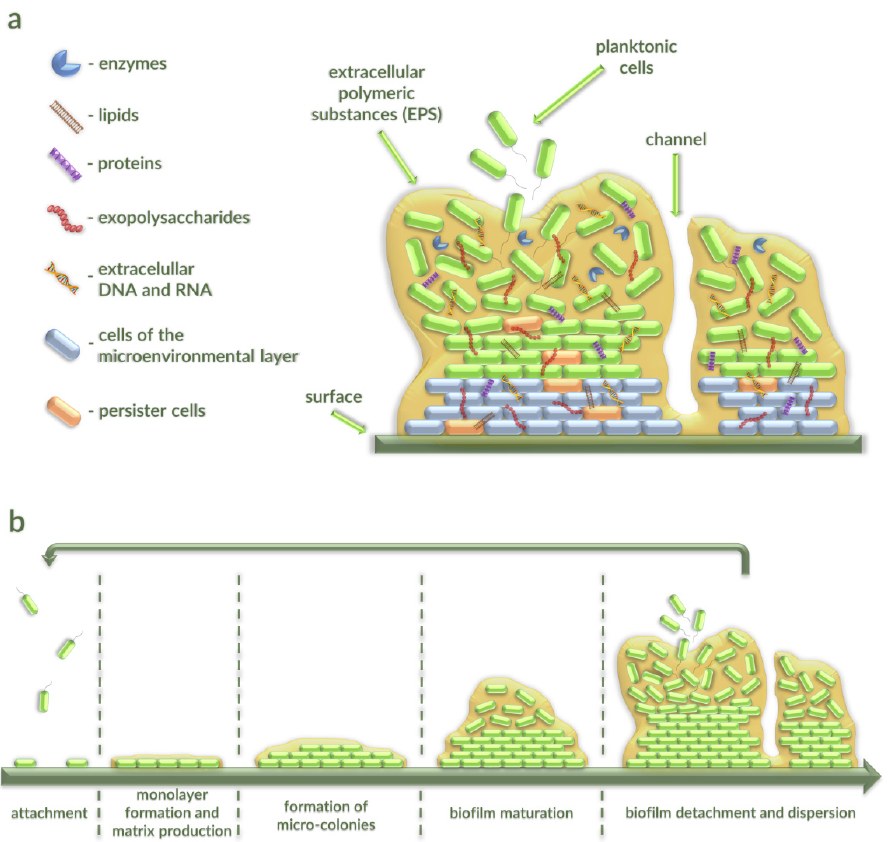
Figure 1. Schematic representation of biofilm components ( a ) and life cycle ( b ). ( a ) The mature biofilm is built with a variety of compounds (DNA, RNA, proteins, lipids, enzymes, and extracellular polysaccharides) called extracellular polymeric substances (EPSs). ( b ) Formation of biofilm starts with attachment of planktonic cells to the surface. Next, bacteria start to form a monolayer and produce the matrix which allows developing the mature biofilm. In the last stage, bacterial cells multiplicate quickly, start to detach, and disperse. This process enables them to convert to motile forms that can spread and colonize new surfaces.